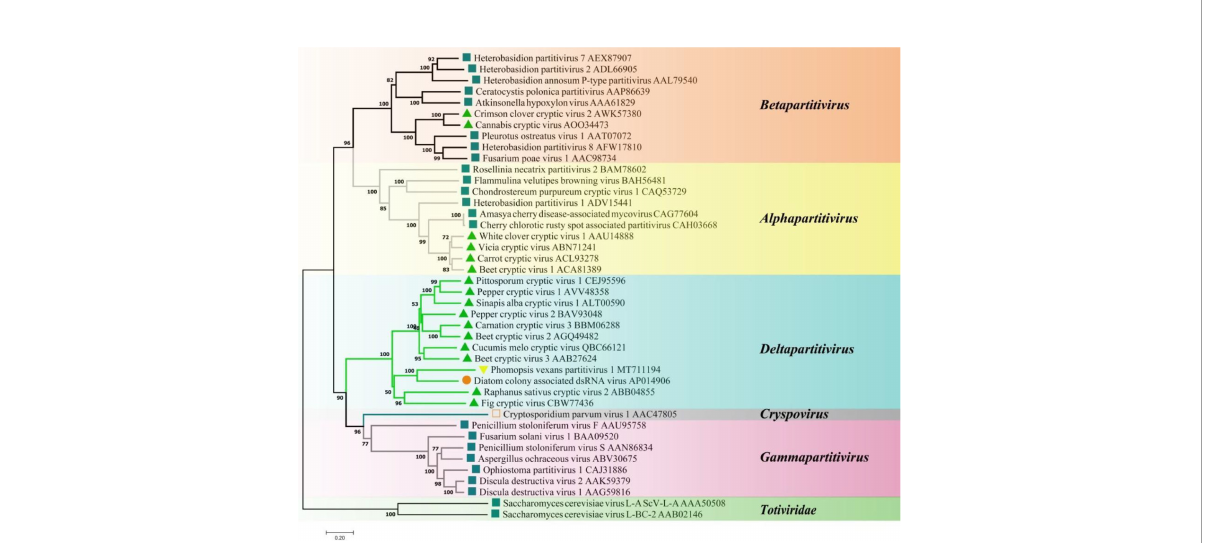
FIGURE 13 Phylogenetic analysis of PvPV1. Phylogenetic analysis illustrating the evolutionary classi fi cation of PvPV1 was conducted using the method described in Figure 7. The scale bar represents a genetic distance of 0.2 aa substitutions per site. Yellow triangles indicate the novel mycoviruses PvPV1 identi fi ed in the present study. The symbols indicate the viruses isolated from the same group of hosts, such as plants (green triangle), fungi (blue square), and protozoa (orange square). The names and database accession numbers of other related viruses analyzed are indicated in the